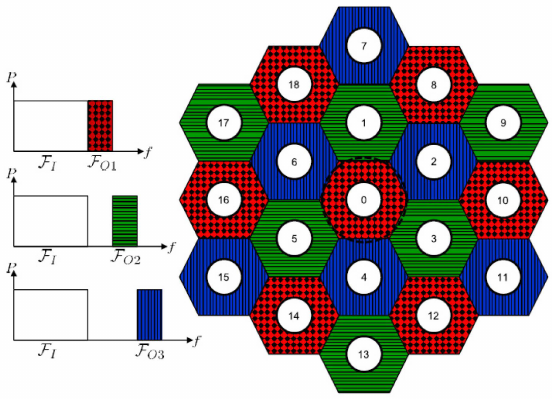
Figure 1. Two-layer FFR network